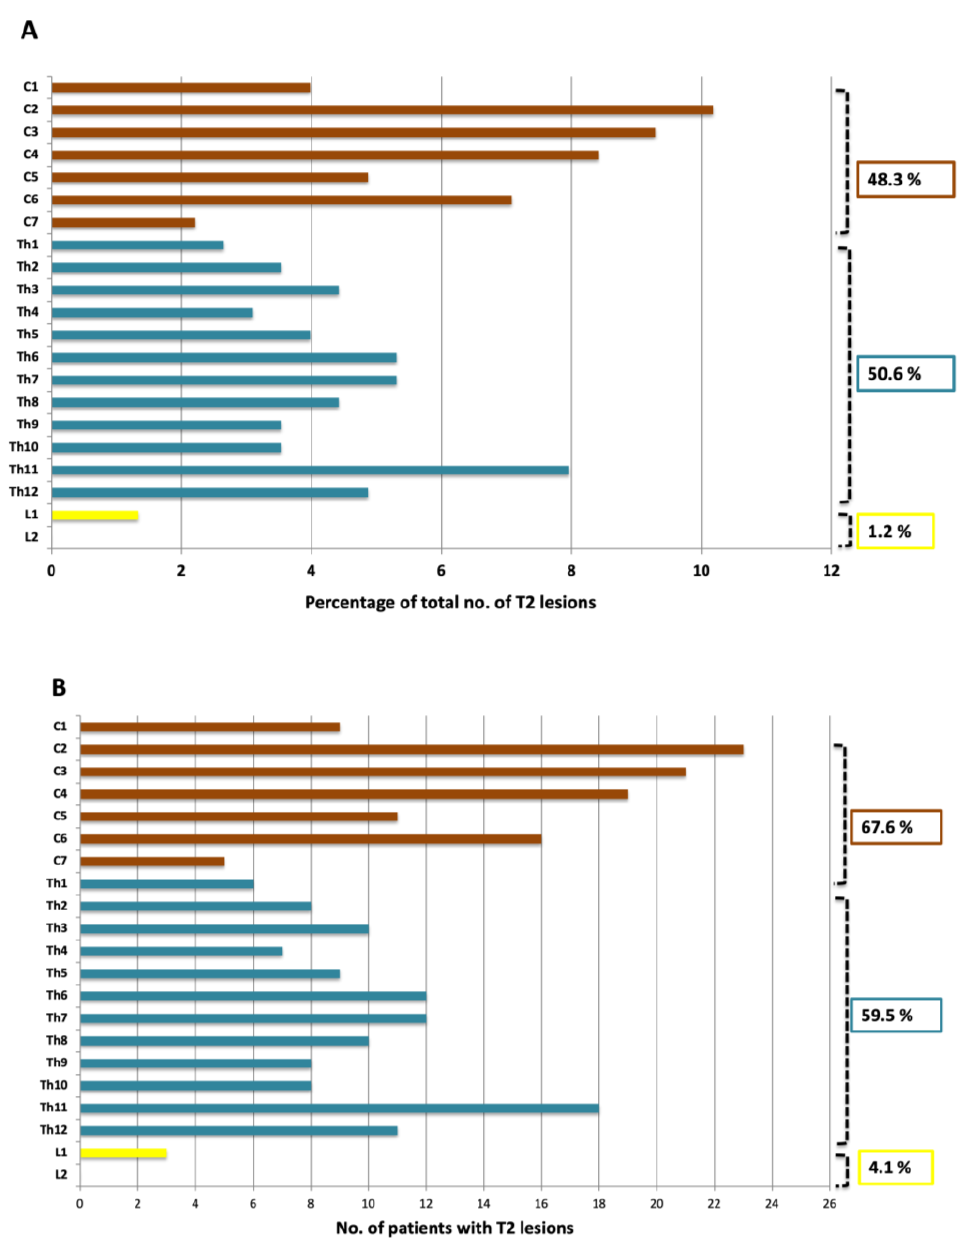
Figure 3. ( A ) Segmental distribution of T2 lesions in the cervical, thoracic and lumbar spine; ( B ) Distribution of patients with lesions in the cervical, thoracic and lumbar spine.